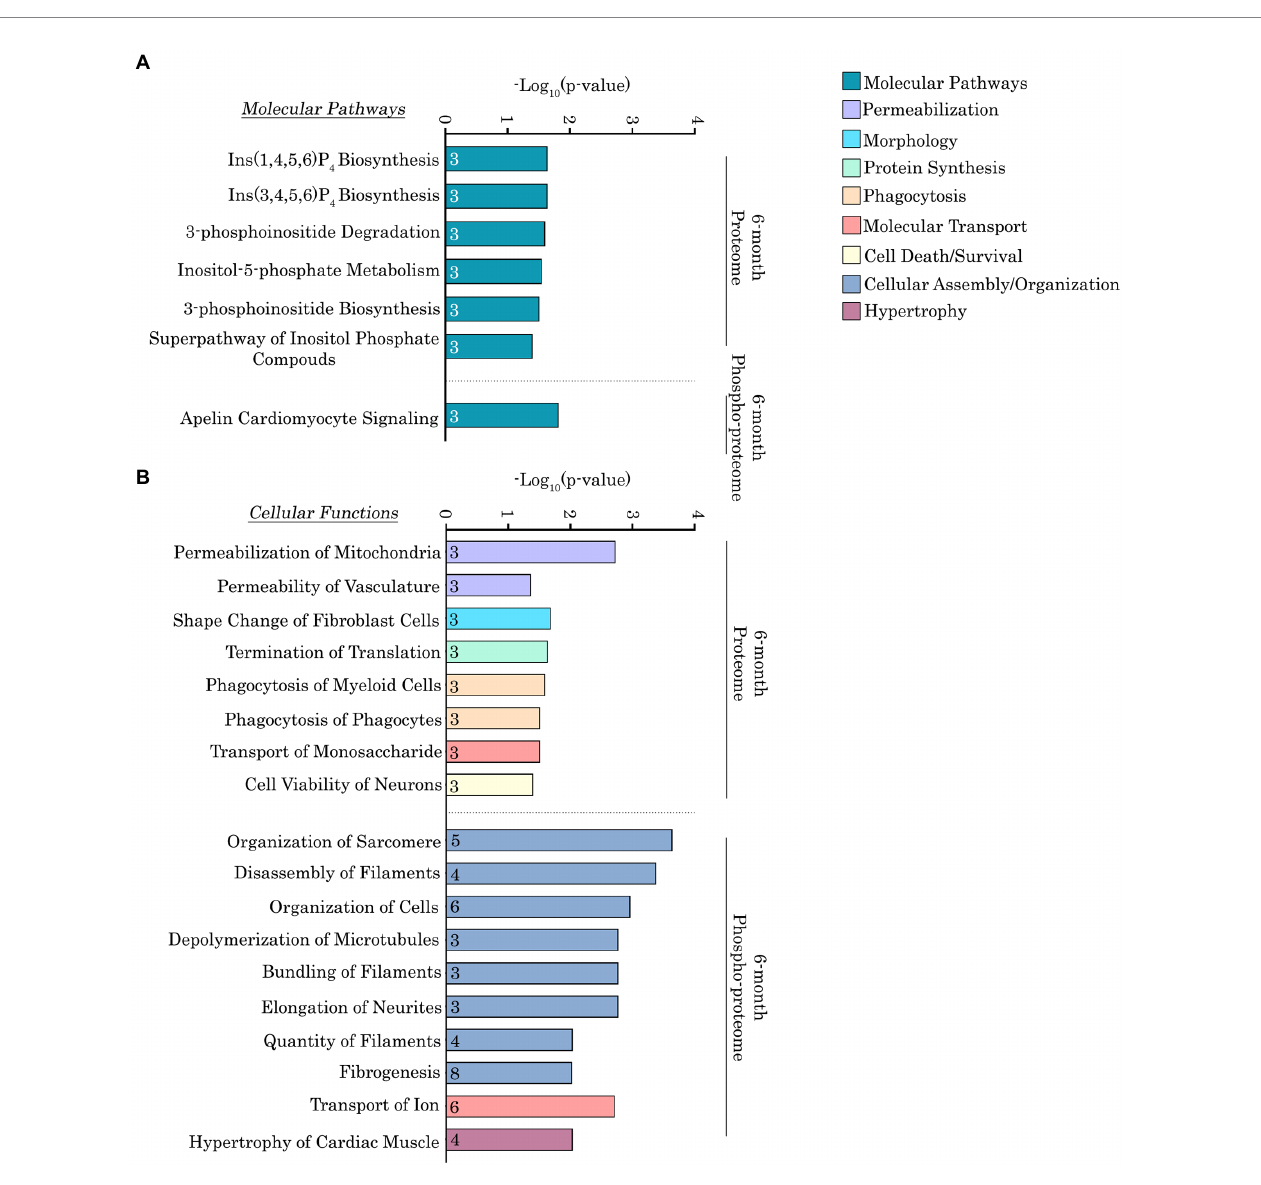
FIGURE 6 Ingenuity pathway analysis of the deregulated proteins and phospho-proteins in Obscn- Δ Ig58/59 atria at 6-months. (A,B) The molecular pathways (A) and cellular functions (B) associated with proteins that exhibited significantly altered expression or phosphorylation in 6-month-old Obscn- Δ Ig58/59 atria. The number of proteins associated with each biological process is indicated within the respective